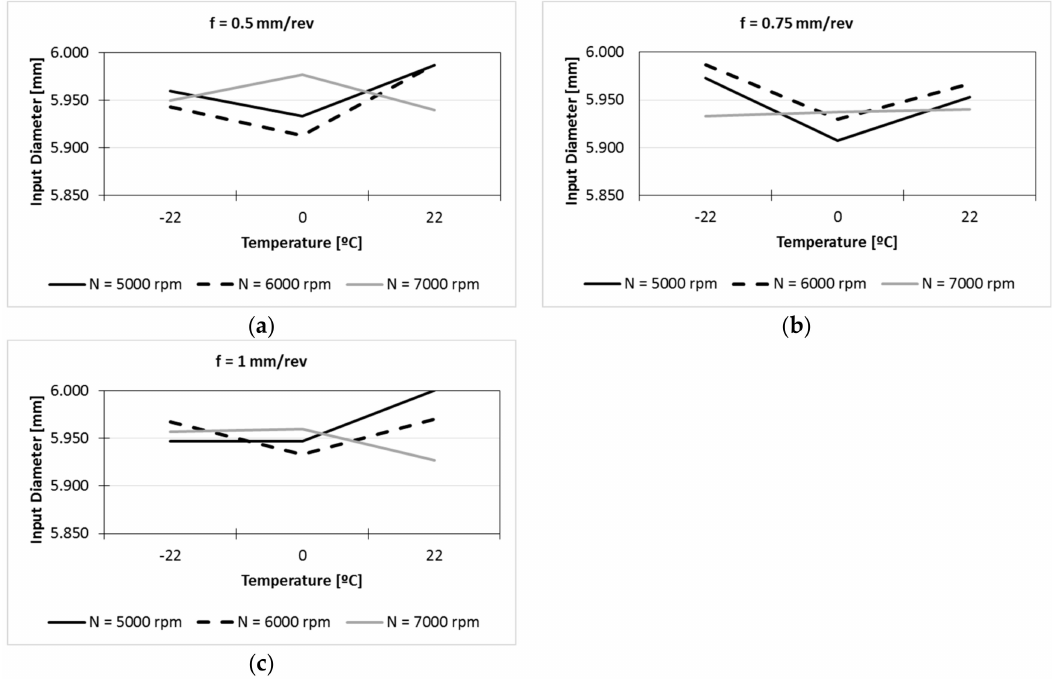
Figure 3. Input diameter executed at di ff erent temperatures and spindle speed, and with: ( a ) feedrate of 0.5 mm / rev; ( b ) feedrate of 0.75 mm / rev; ( c ) feedrate of 1 mm /